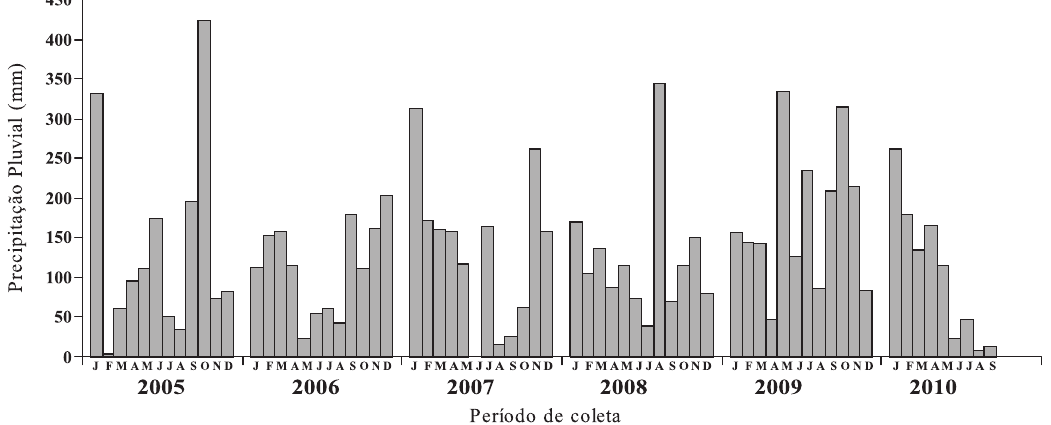
Figura 1. Valores médios mensais de precipitação pluvial na área do experimento. As letras representam as iniciais de cada mês, de janeiro até